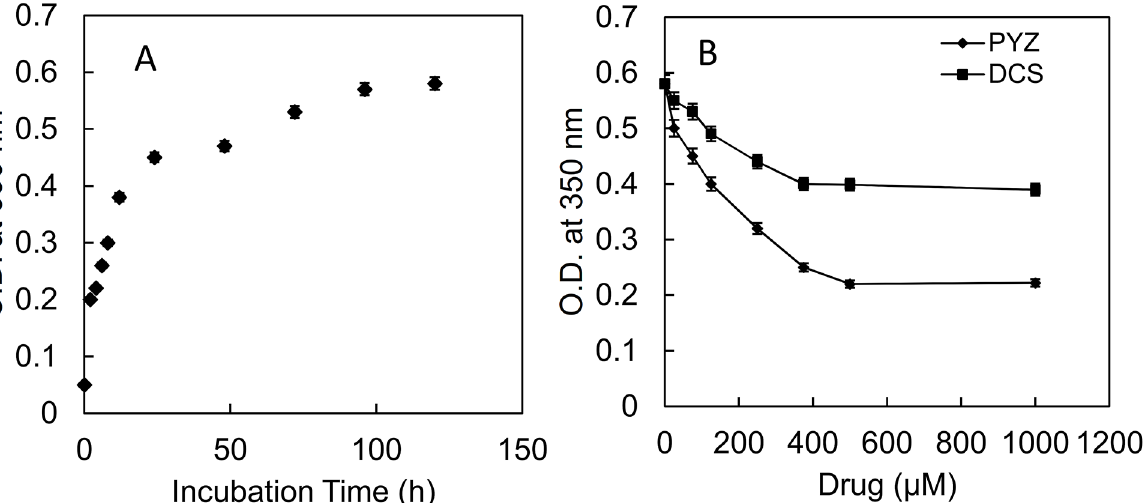
Fig 1. Turbidity measurements by recording O.D. at 350 nm. (A) HEWL incubated at 65°C over a period of 120 h (B) HEWL incubated at 65°C (120 h) in presence of different concentration of PYZ and DCS at 120 h. The maximal concentration of PYZ (1000 μ M) and DCS (1000 μ M) were taken as control and has negligible O.D. at 350 nm.